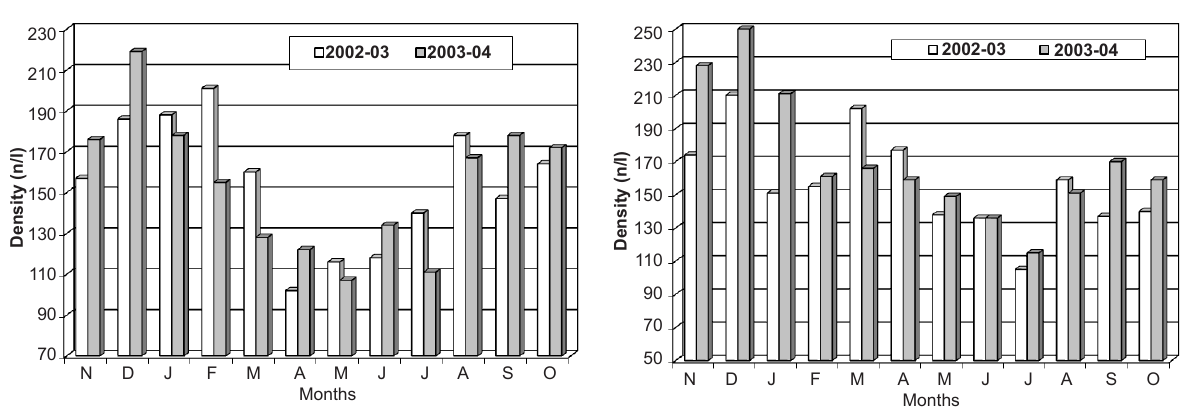
Figure 7. Monthly variations in abundance of phytoplankton of Utra Pat